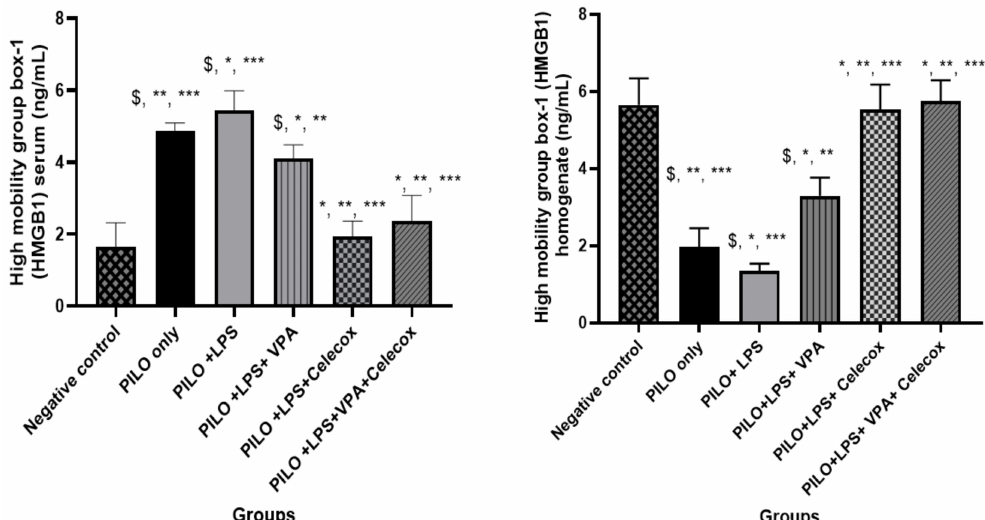
Figure 4. Effects of test drugs on high mobility group box-1 (HMGB1) levels in the serum and homogenate in rats of different groups. Data were expressed as mean +/ − standard deviation. PILO: pilocarpine, LPS: lipopolysaccharides; VPA: valproic acid, Celecoxib: celecoxib. Comparison between groups was made using One-way ANOVA test followed by Tukey’s multiple comparison test. * p < 0.05 comparison versus PILO only; ** p < 0.05 comparison versus PILO+LPS, *** p < 0.05 comparison versus PILO+LPS+VPA, $ p < 0.05 comparison versus negative control group.